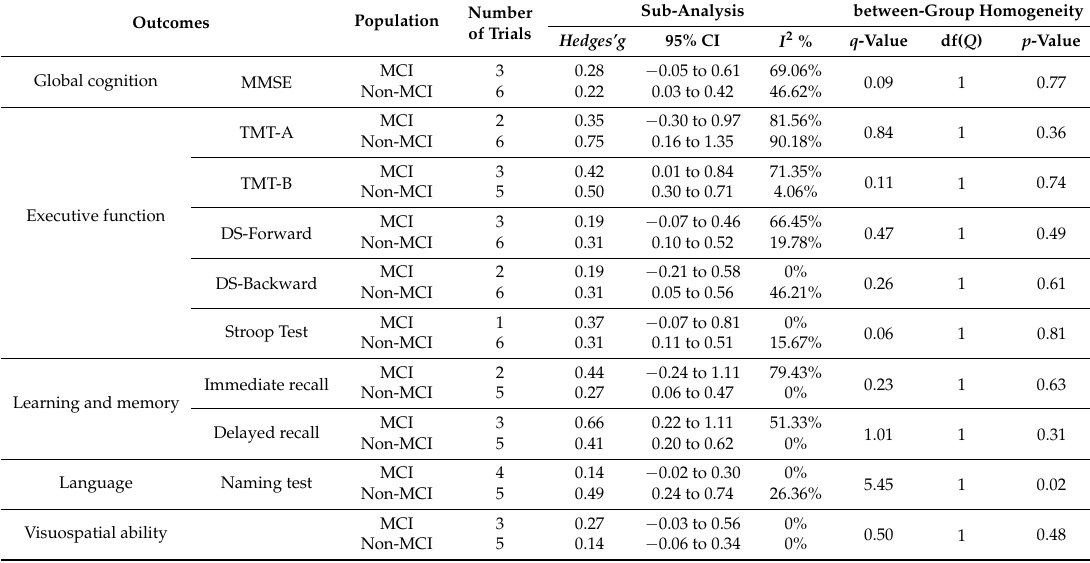
Moderator analysis for the effects of mind-body exercise vs control intervention (categorical